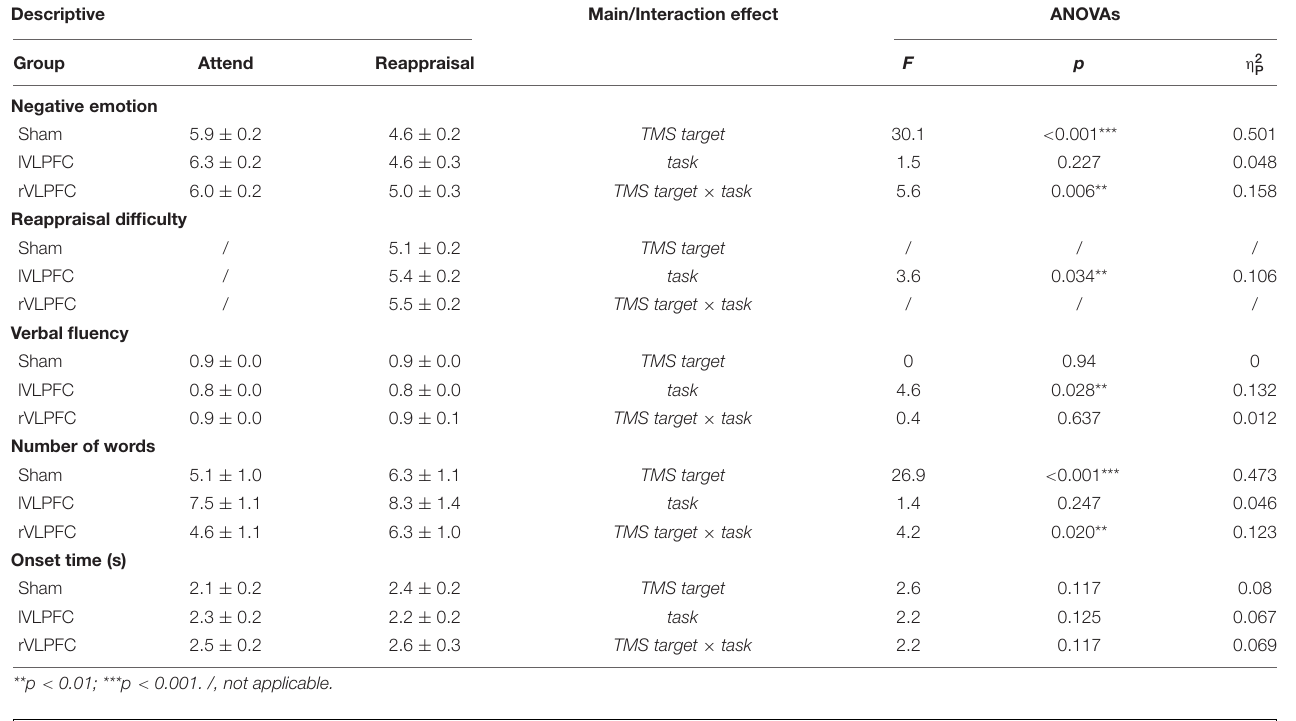
TABLE 1 | Descriptive statistics (M ± SD) and results of ANOVAs.